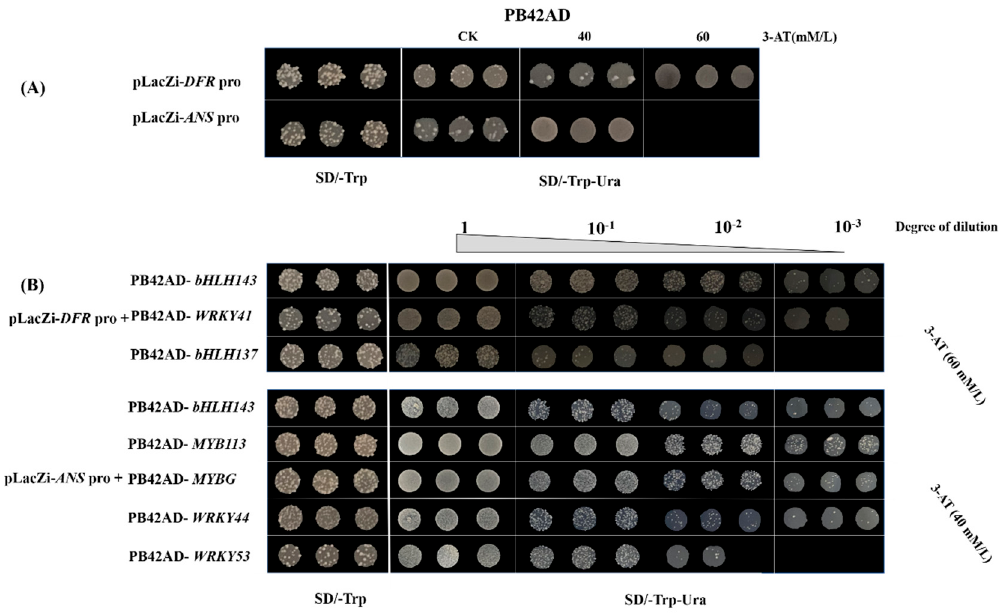
Figure 3. CabHLH143, CaWRKY41 and CabHLH137 interacted with the promoter of CaDFR , and CabHLH143, CaMYB113, CaMYBG, CaWRKY44 and CaWRKY53 interacted with the promoter of CaANS . ( A ) Growth conditions of PLacZi- DFRpro + PB42AD and PLacZi- ANSpro + PB42AD on SD/-Trp and growth conditions on SD/-Trp-Ura of different concentrations of 3-AT. ( B ) The interaction between CaDFR and anthocyanin-biosynthesis-related TFs and between CaANS and anthocyanin-biosynthesis-related TFs in yeast cells, respectively. Four black squares of SD-Trp-Ura (from left to right) represent four dilution concentrations. There are basically three replicates for each concentration of each